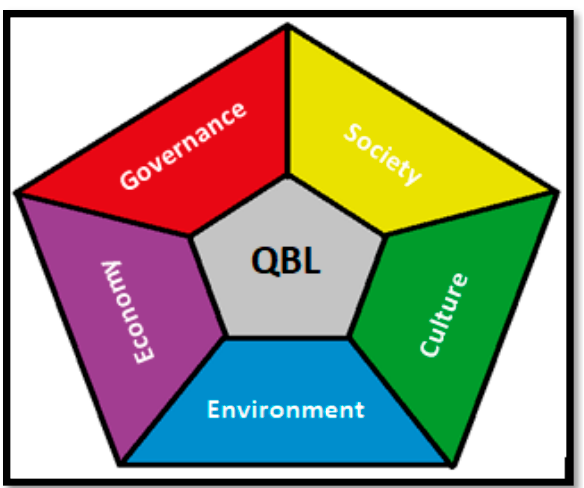
Figure 2. Quintuple bottom line approach developed based on an extensive